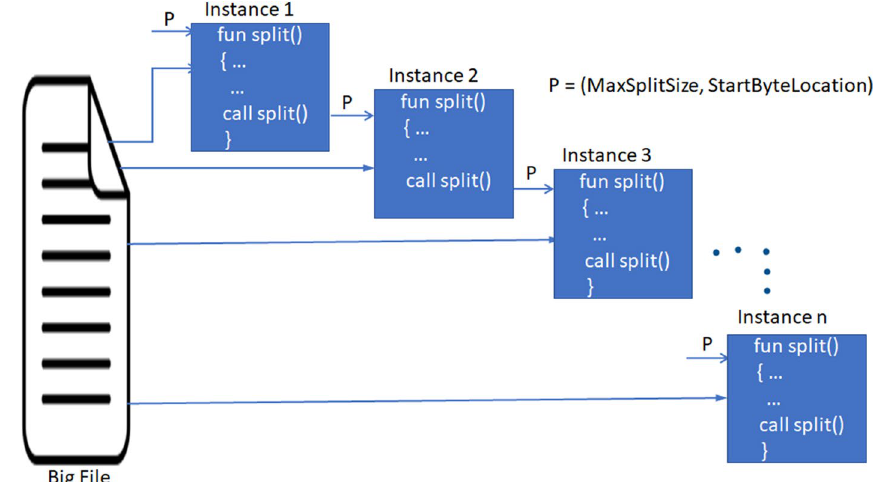
Fig. 3 Relay Composition used in spitting a big